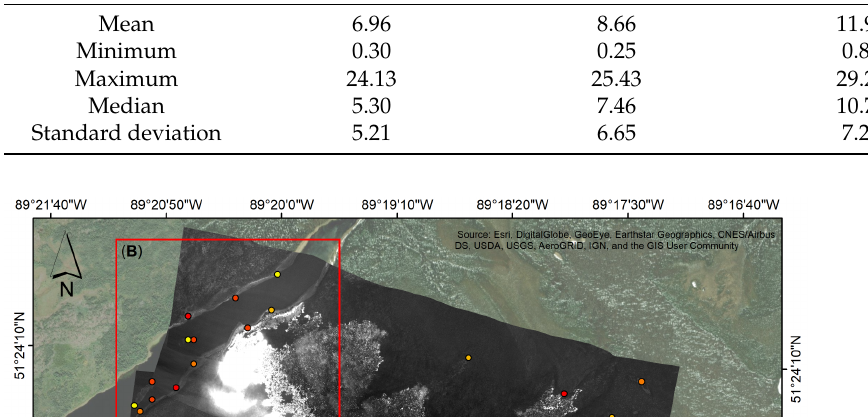
Table 4. Reported absolute (Abs.) georeferencing errors for the FLIR imagery acquired on 3 August 2017, at the longest integration time of 1.4 ms of the five processed flight lines. Results reported over 51 pseudo-ground control points (PGCPs).